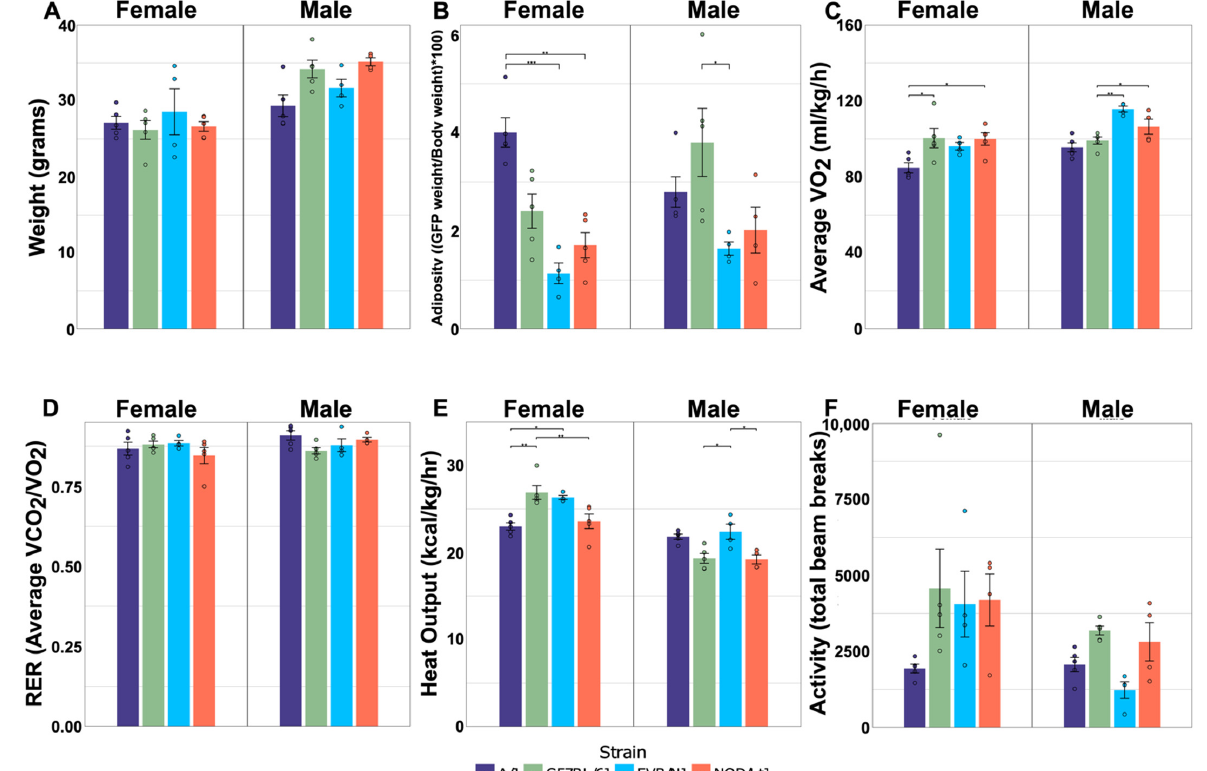
Table 1. p -values for effects of sex, strain, and sex-by-strain interaction on weight and metabolism.